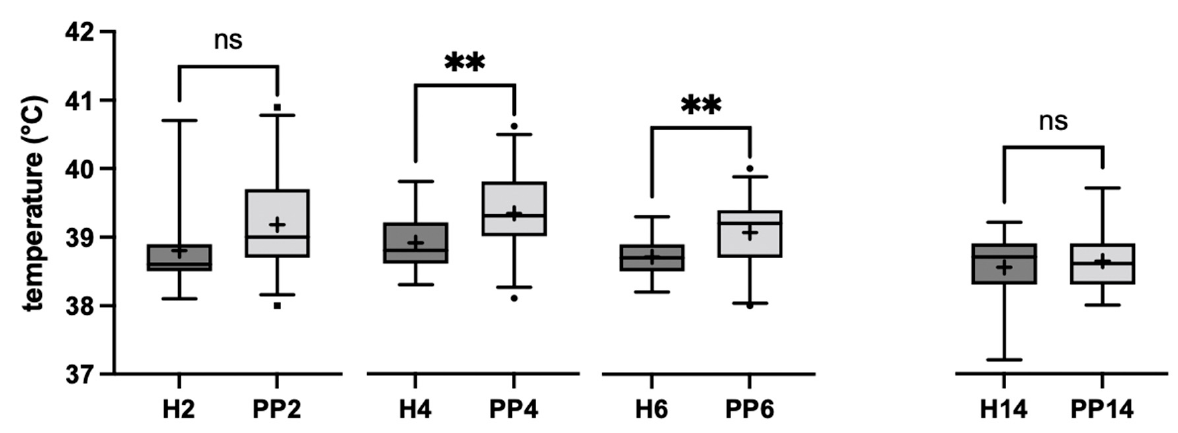
Figure 4. Rectal body temperature of healthy cattle (H # , n = 19) and cows with a pathological puerperium (PP, n = 27) on day 2, 4, 6 and 14 after calving. Unpaired t-test: ns = not significant; ** p < 0.01. Box = from the 25th to 75th percentile; midline = median value; plus = mean value; whiskers = 5–95 percentile; # = one healthy cow showed fever due to a different diagnosis.